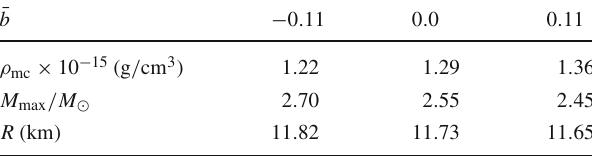
Table 6 The maximum masses and the corresponding radii for three- form field quark stars in the presence of a Higgs-type potential